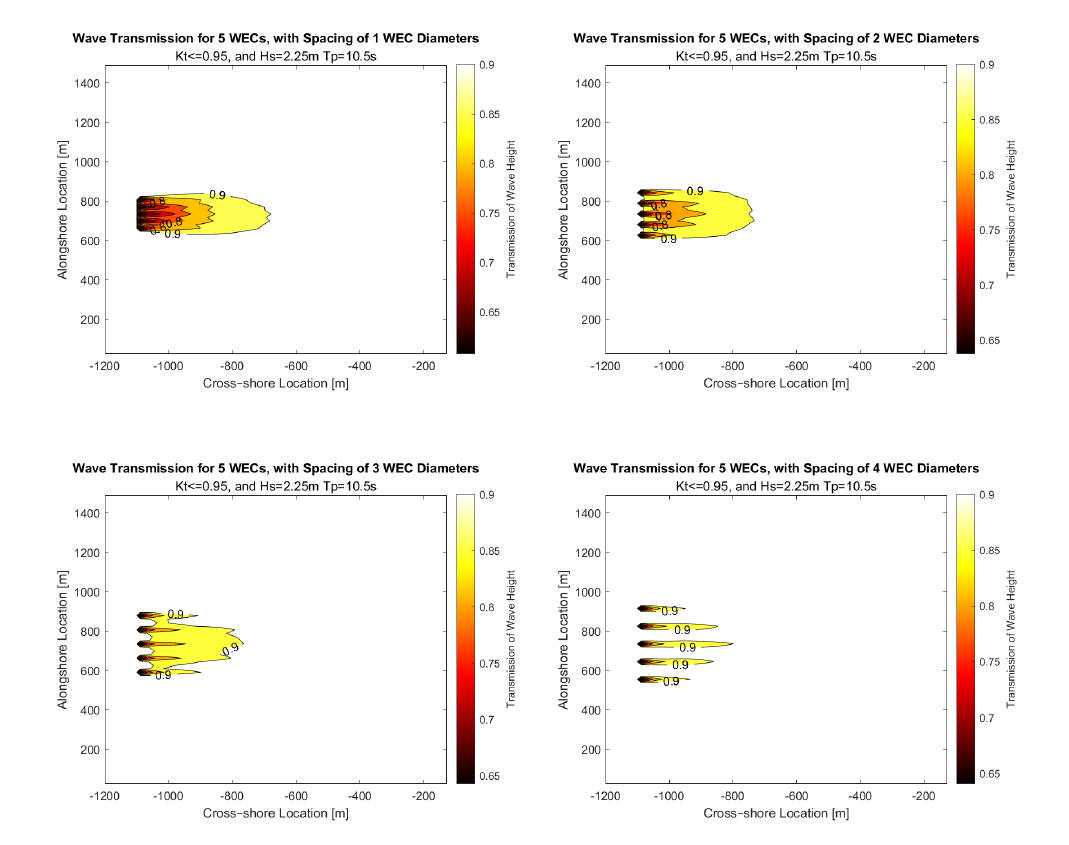
Figure 12. Normalized wave transmission magnitude and extent of wave transmission influence in the lee of the 5 WEC array. The color bar shows the percentage of transmission in the wake region.